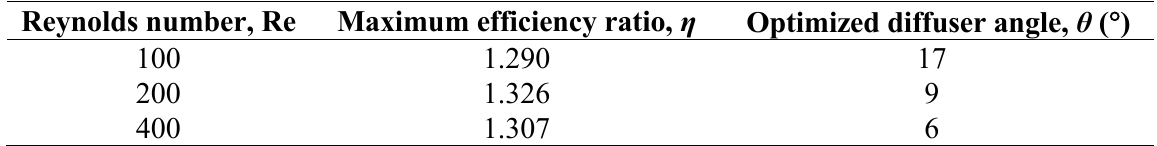
Table 7. Maximum efficiency ratio obtained using GA for different diffuser angle. Reynolds number, Re